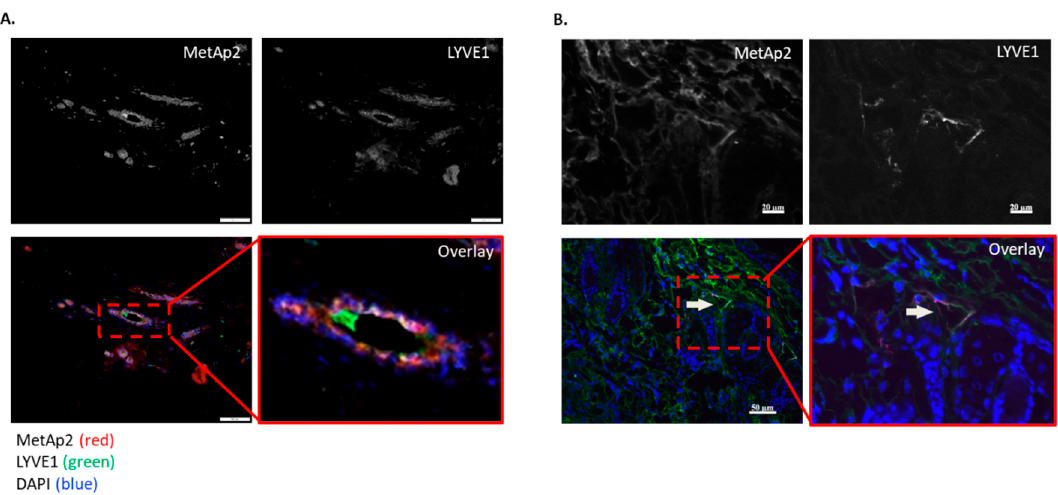
Figure 1. Cancer tissue samples retrieved from two breast cancer patients express MetAp2 and LYVE1. ( A , B ) Immunofluorescence staining of MetAp2 (red), LYVE1 (green), and DAPI (blue) reveal lymphatic structures co-localized with MetAp2 expression. Black and white images represent fluorescence in a single channel. Left panel scale bar = 100 µ m. Right panel scale bar = 20-50 µ m.